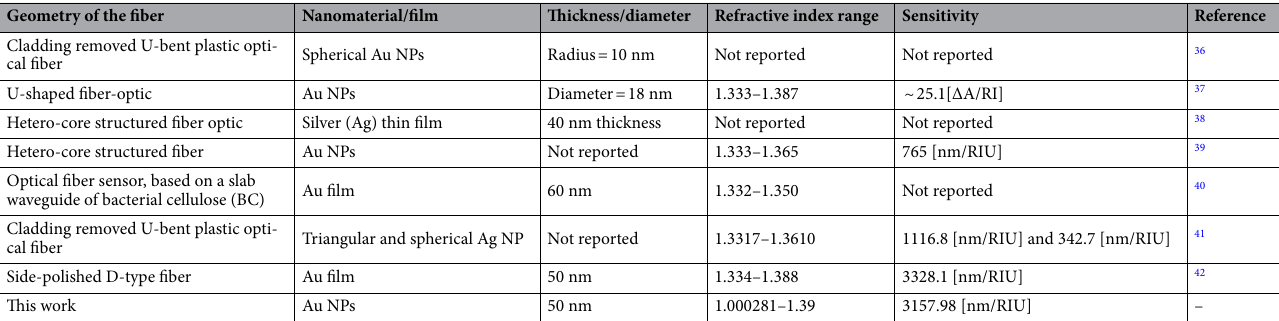
Table 3. Presents a comparison between this work and previous